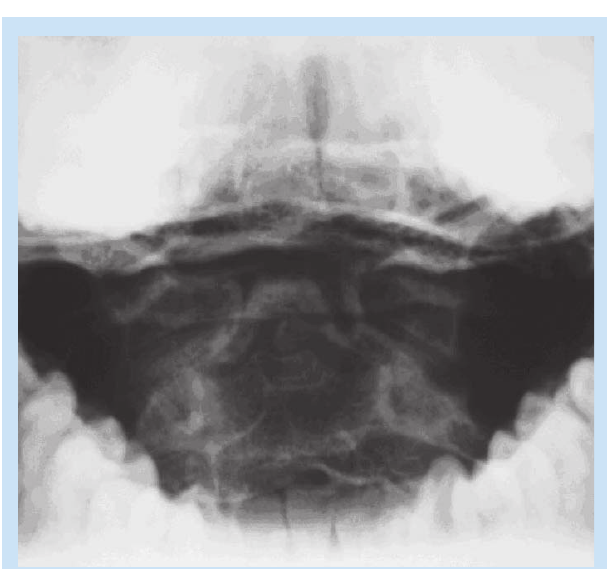
Fig. 2. Open mouth view demonstrating a small cupola-shaped